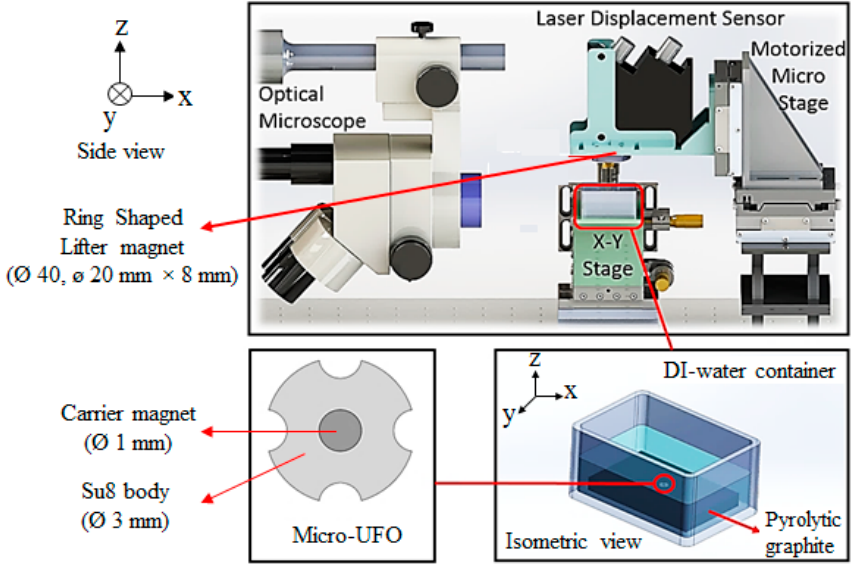
Figure 2. Shows the whole experimental setup with dimensions. The control of the motorized micro stage where lifter magnet is attached, is realized through a control interface programmed in Visual C#.Net platform (Microsoft Corporation, Redmond, WA, USA). Camera image is transferred to the same interface simultaneously. The data of laser displacement sensor is acquired through the sensors’ own